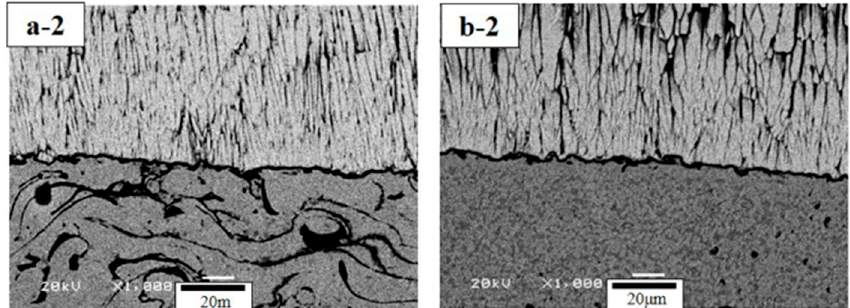
Figure 1. Cross-sectional microstructures of as-prepared TBCs: APS bond coat TBC system (the overall ( a–1 ) and the interface ( a–2 ) microstructures), and HVOF bond coat TBC system (the overall ( b–1 ) and the interface ( b–2 ) microstructures).